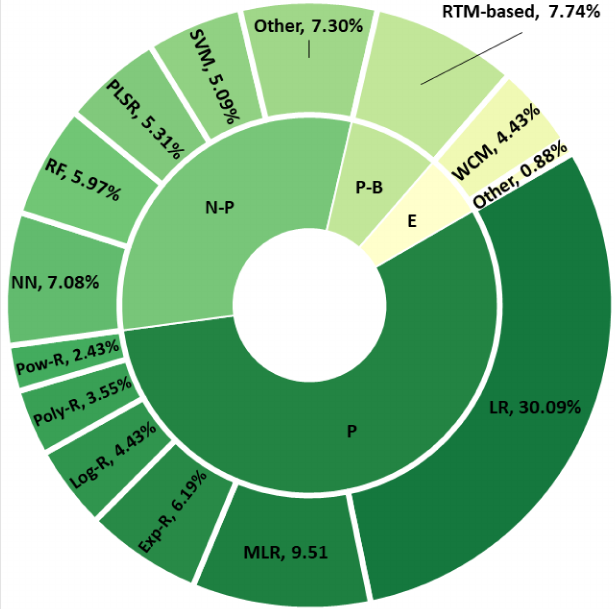
Figure 13. Methods used to estimate crop parameters from remote sensing